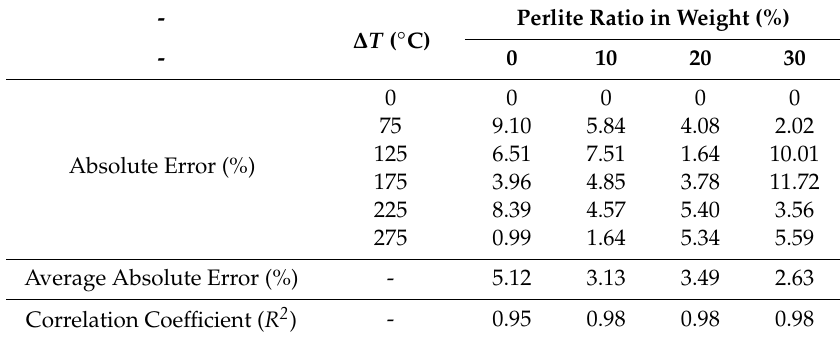
Figure 10. The regression analysis results of the thermal softening parameter of HESC with ( a ) 0% perlite ( λ = 0.00341), ( b ) 10% perlite ( λ = 0.00238), ( c ) 20% perlite ( λ = 0.00223), ( d ) 30% perlite ( λ = 0.00229). Table 15. Absolute errors and correlation coefficients between the experimental and analytical results.